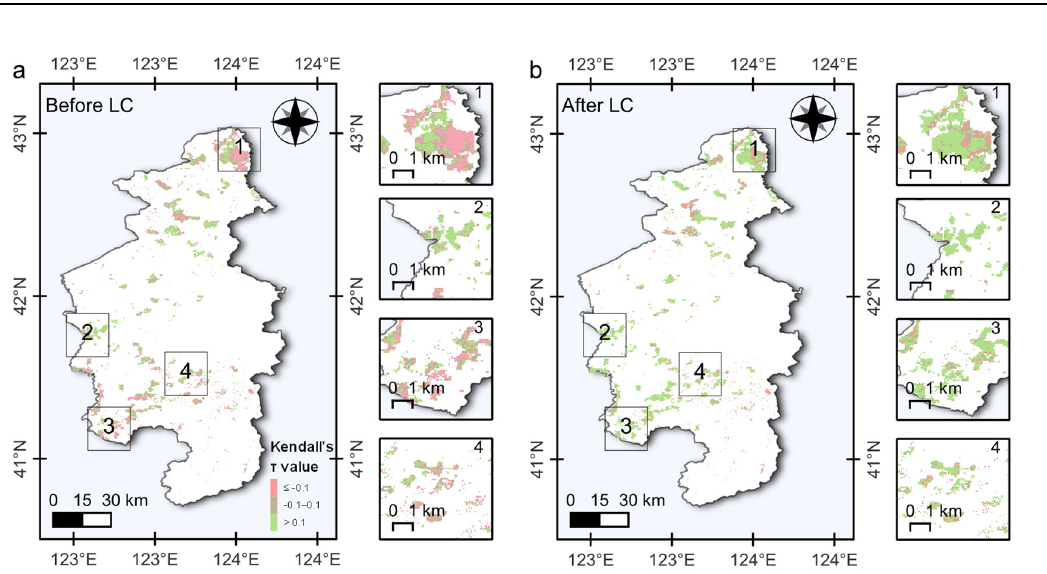
Figure 9. The comparison between FC areas and the plots without FC based on Kendall’s τ value ( a ); the comparison between FC areas and the plots without FC based on Theil–Sen slope ( b ). The Gini coefficients are shown along the scale of the x ‐ axis. 4. Discussion 4.1. Ecological–Environmental Quality Monitoring at a Large Regional Level This study described the spatiotemporal changes in the EEQ in a large region caused by agricultural land consolidation. According to descriptions in other studies, land con ‐ solidation projects are considered to be an effective instrument to promote plant biomass, optimize the landscape pattern, and change the structure and function of the regional eco ‐ system [58,59]. However, it is difficult to analyze the impact of numerous FC projects on the EEQ of a large region. The construction of the RSEI model requires a large amount of image data at a regional level and a long ‐ term time scale, which greatly increases the cost of analysis and monitoring. According to descriptions in another study, the EEQ monitor ‐ ing of FC was limited to spatiotemporal scales, which studied the impacts of one ‐ year FC